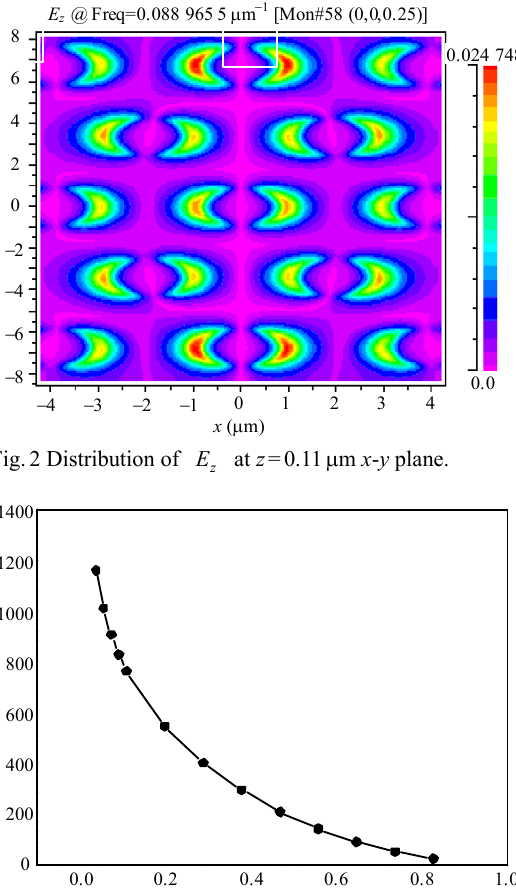
Fig. 5 Relative coupling efficiency with respect to duty ratio D / P